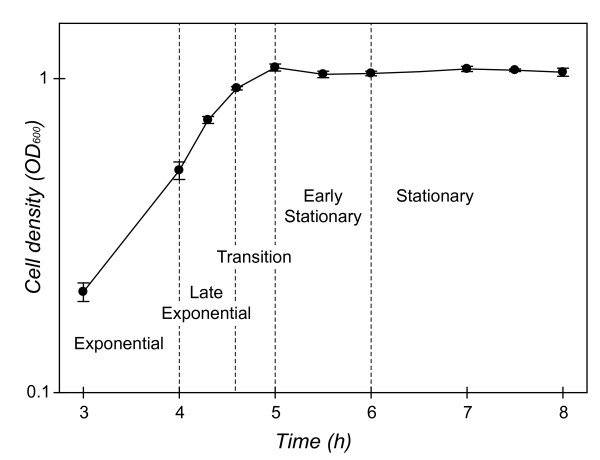
Average growth of E. coli O157:H7 Sakai in MOPS minimal medium. Increase in cell density is measured at OD600 at 10 time periods (hr) of growth into stationary phase. Error bars represent the standard deviation of four culture replicates. Samples were taken from the culture at the time points plotted and RNA was extracted. The 5 growth phases, separated by dotted lines, are defined as exponential growth, late exponential growth, transition to stationary phase, early stationary phase, and stationary phase.